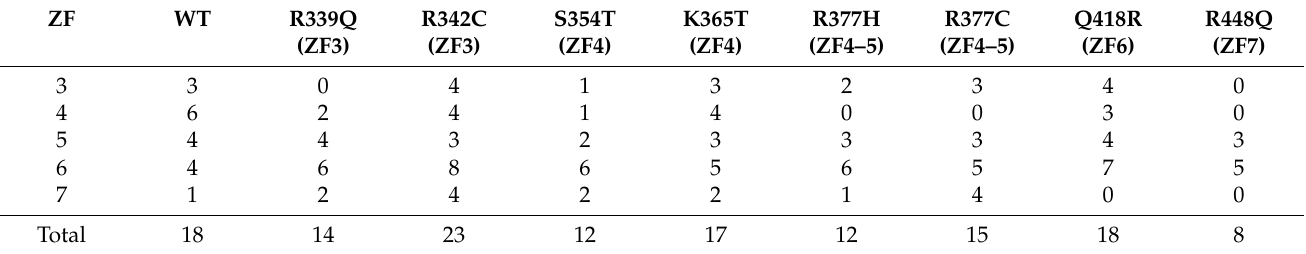
Table 2. Number of hydrogen bonds in each ZF and within the complex are sensitive to CTCF mutations in CTCF–DNA complexes. Values are measured over the last 100 ns of the trajectory for each of the five trajectories per